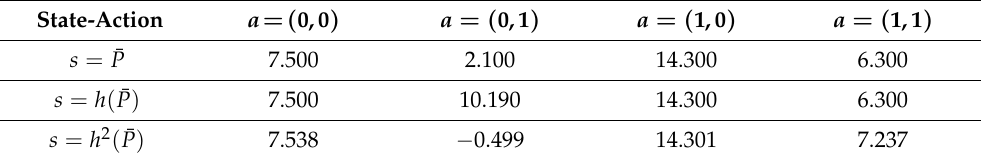
Table 1. (cid:101) Q ∗ ( s , a s , a a ) for reliable channel.